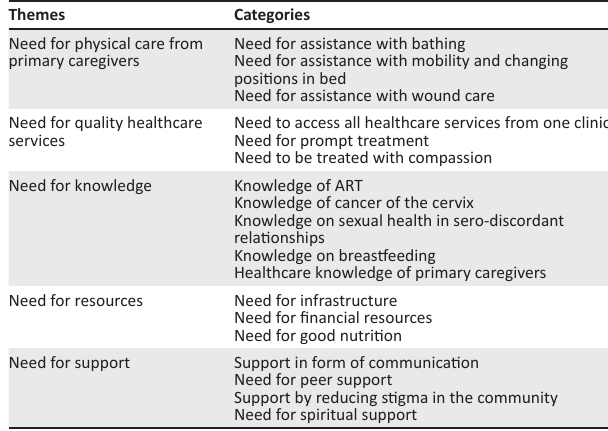
TABLE 2: Themes and categories that